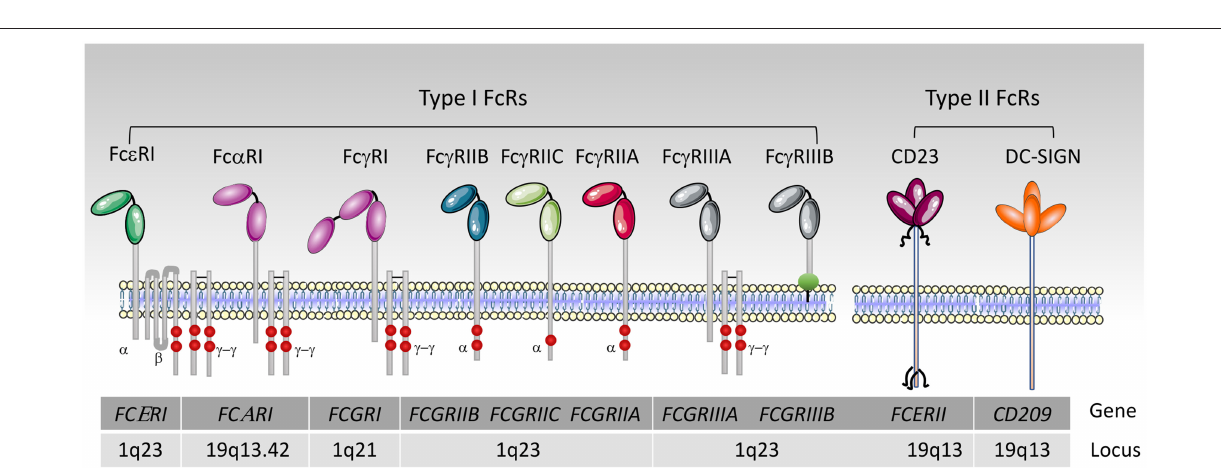
FIGURE 3 | Human type I and II Fc receptors . Schematic representation of human Fc receptors at the cell membrane and their association or not with the FcR γ -chain dimer and the Fc ε RI β chain, red circles represent the tyrosine residues. The Fc γ RIIIB is anchored into the outer leaflet of the plasma membrane by a phosphatidylinositol-glycan (green